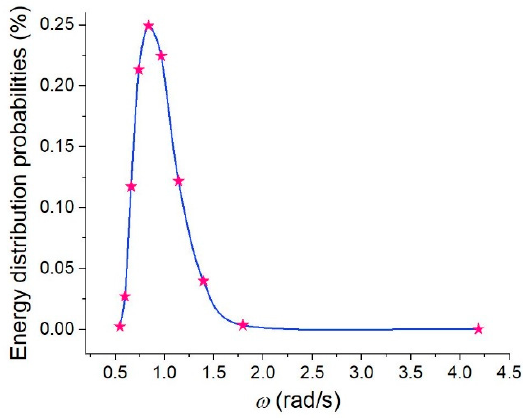
Figure 4. Energy distribution probabilities under different wave frequencies.